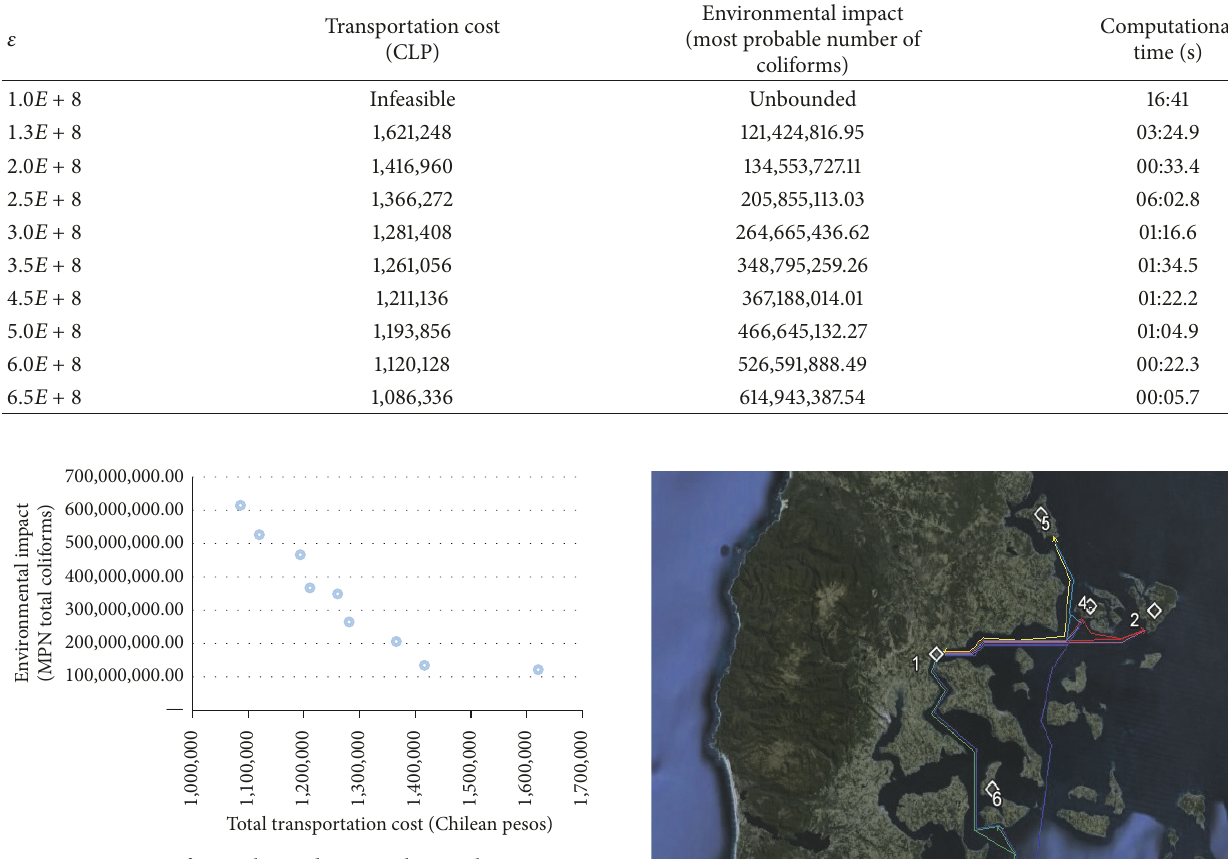
Figure 8: Pareto front obtained using the epsilon-constraint method.